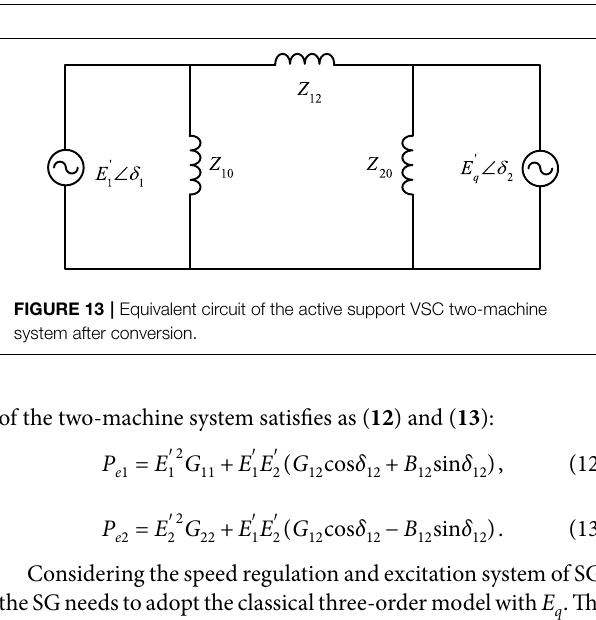
FIGURE 12 | Equivalent circuit of the actively support VSC two-machine system.